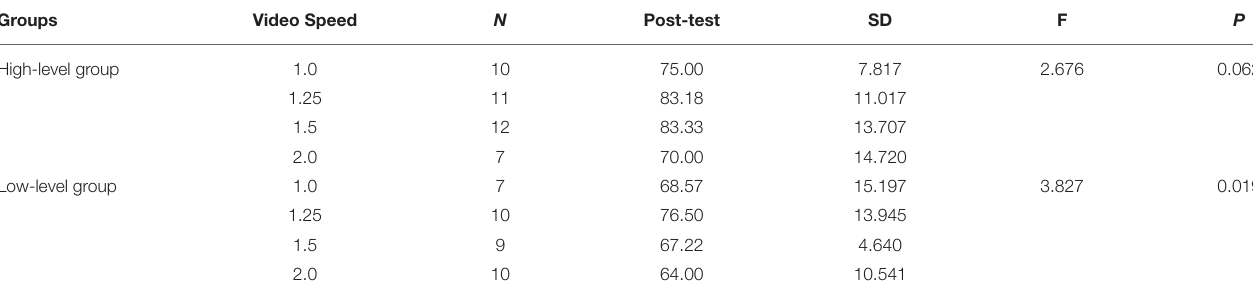
TABLE 4 | Influence of video speed and learning ability on learning effect shown by covariance analysis. Groups High-level group